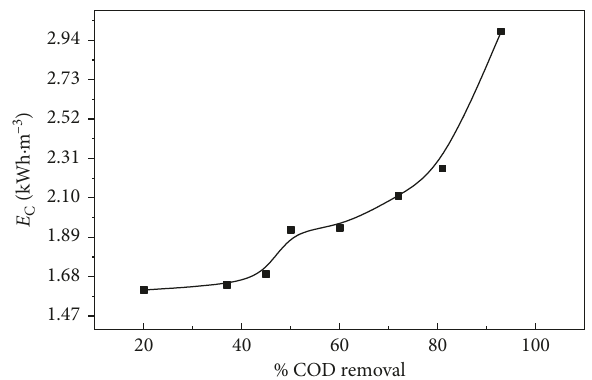
Figure 10: Evolution of energy consumption ( E removal during the electrochemical treatment under optimum conditions ([NaCl]: 0.07mol · L − 1 , [Rh-B]: 200mg · L − 1 , current density: 3.9mA · cm − 2 , T : 25 ° C, flow rate: 30 L · h − 1